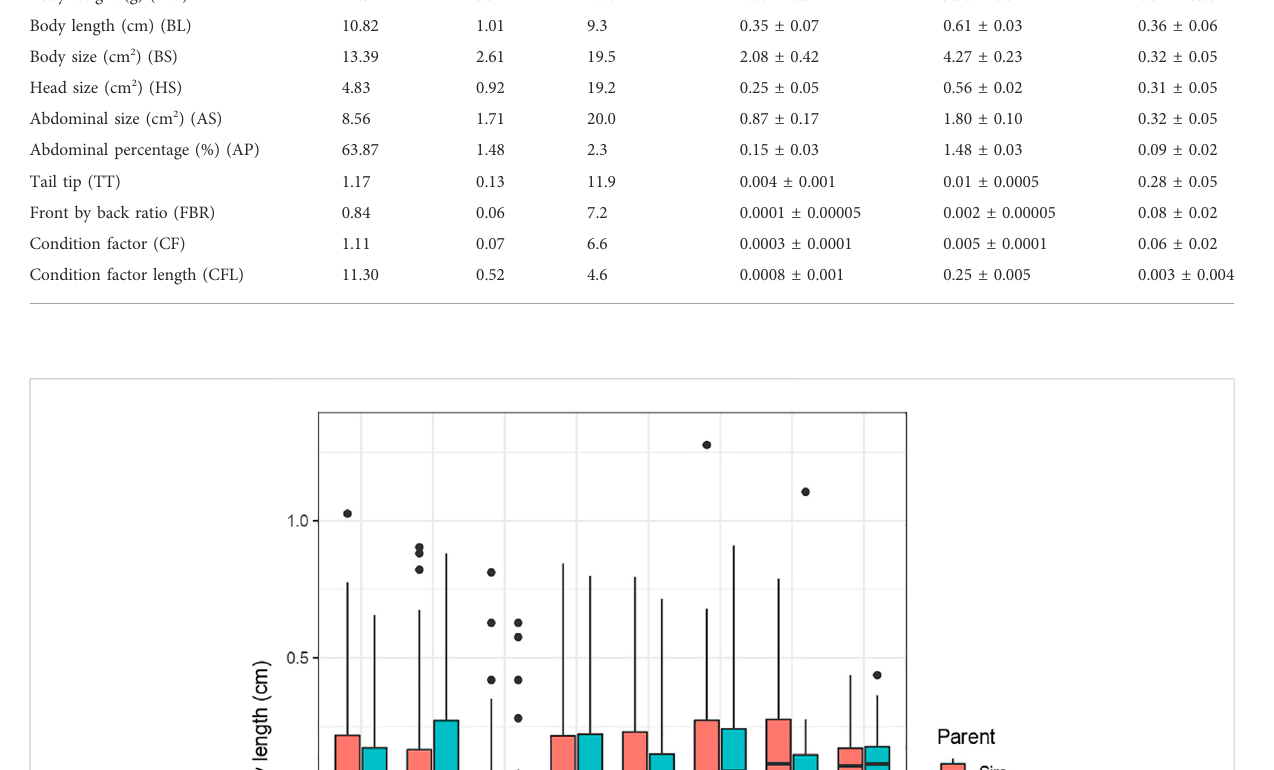
Genetic correlations ( r g ) among BW, BL, BS, HS, AS and TT were high (range: r g = 0.96 – 0.99) (Table 4). The r g was medium with AP trait with the abovementioned traits (range: